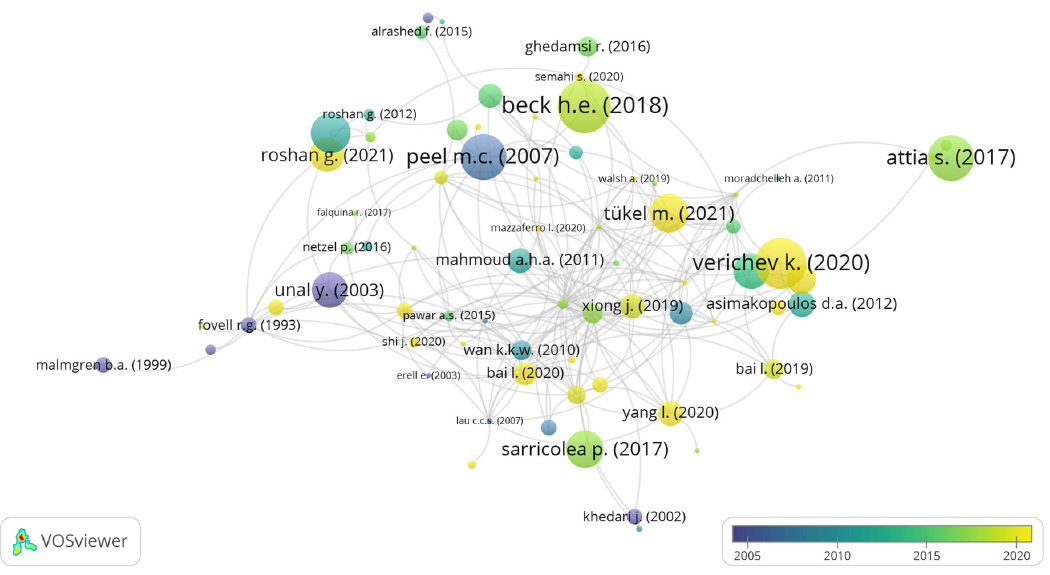
Figure 19. Direct citation network of articles.